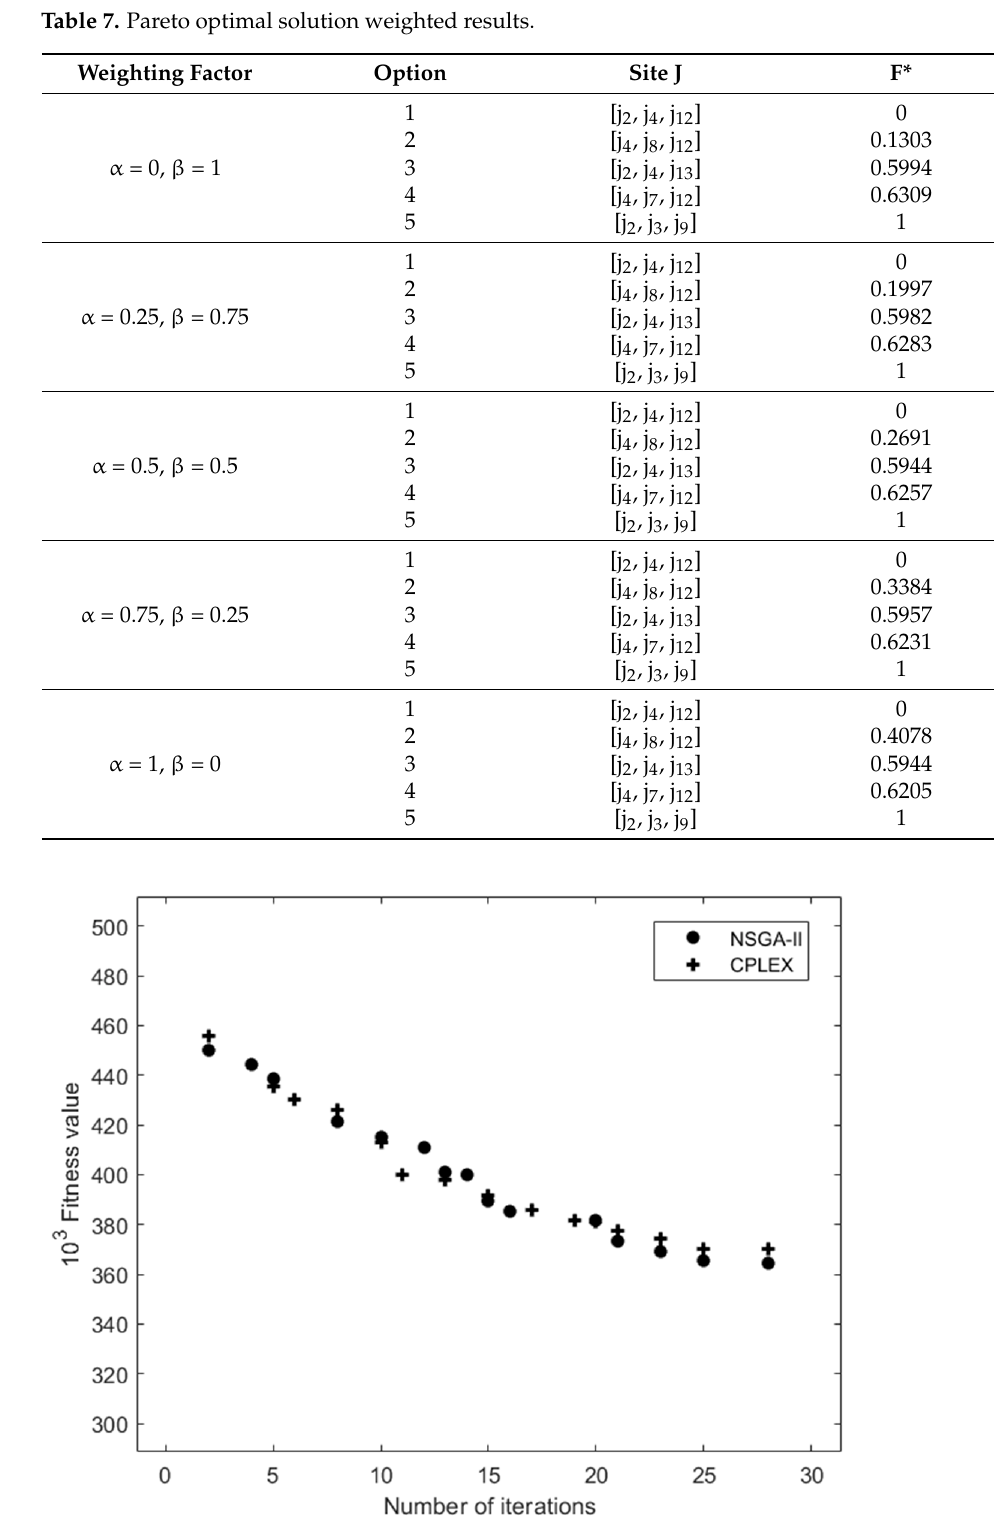
Figure 8. Plot of the iteration of the fitness value for Scenario 1.